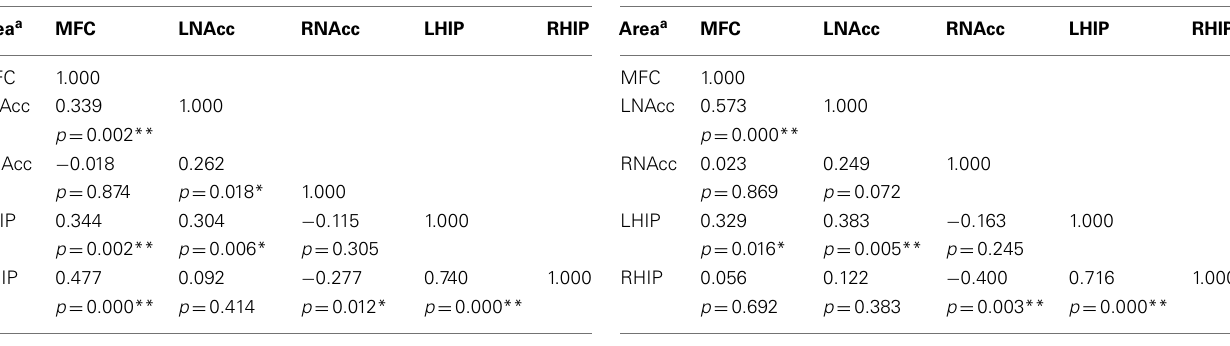
Table 5 | Functional connectivity between regions of interest during all three task conditions at week one.